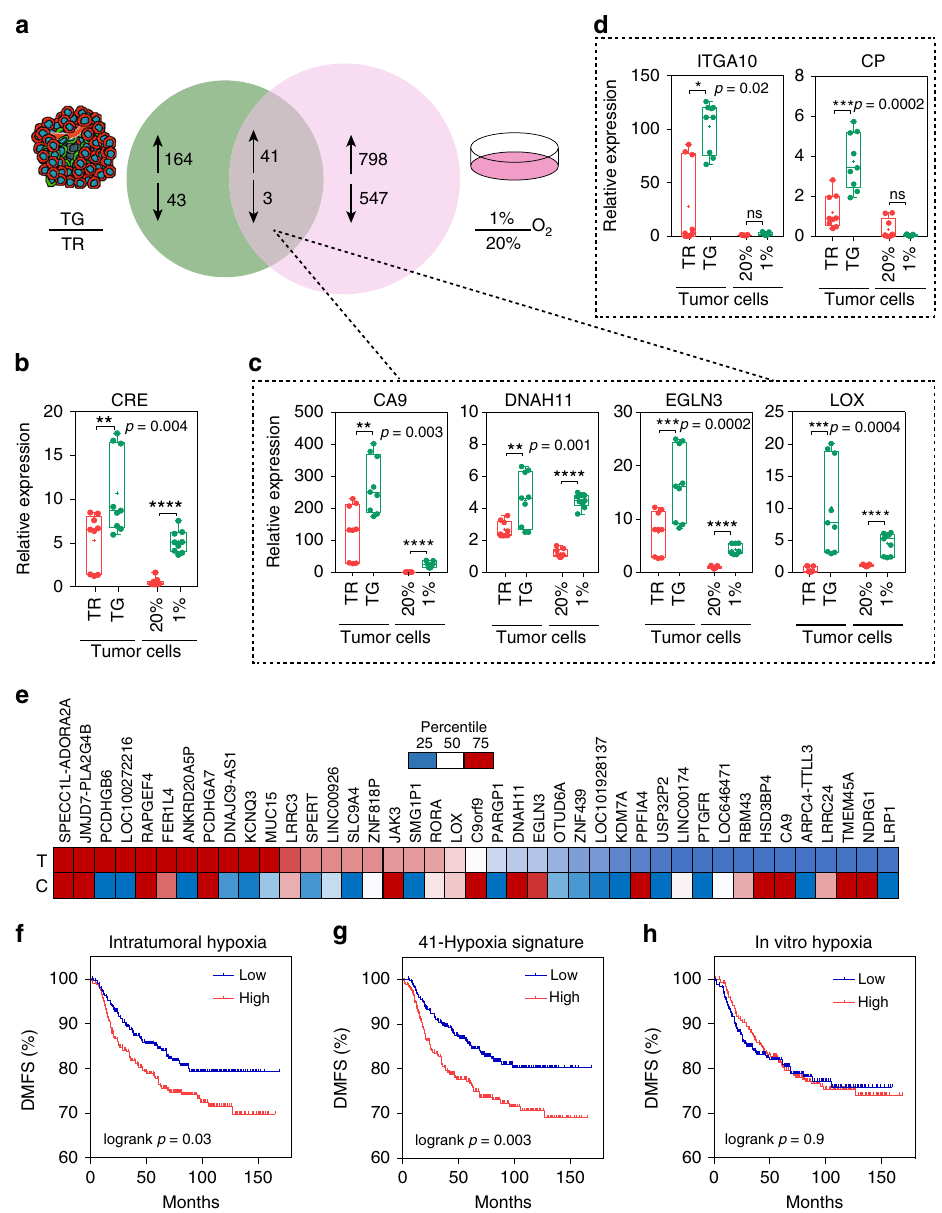
Fig. 5 Hypoxia fate-mapping system facilitates pro fi ling of intratumoral hypoxia. a Tumors derived from hypoxia fate-mapping MDA-MB-231 cells were harvested 2 weeks after implantation and sorted into DsRed + /GFP − or GFP + populations directly into Trizol ( N = 2). Venn diagram displaying the overlap of the number of genes with differential expression ( − 1.5 ≥ FC ≥ 1.5) in GFP + versus DsRed + tumor cells (green circle) and MDA-MB-231 cells exposed to 1% O 2 versus 20% O 2 (pink circle) (Supplementary Table 6). b – d Relative expression of mRNA measured by qPCR in tumor-derived cells (TG or TR) or MDA-MB-231 cells exposed to 20% or 1% O 2 in vitro, b CRE, c genes co-regulated by intratumoral and in vitro hypoxia (CA9, DNAH11, EGLN3, and LOX), and d genes exclusive to upregulation upon intratumoral hypoxia (ITGA10 and CP) (mean± SEM, N = 3, n = 3); **** P < 0.0001 TG versus TR and 1% versus 20% (two-tailed t -test). The box extends from the 25th to 75th percentiles, the median is marked by the vertical line inside the box, and the whiskers represent the minimum and maximum points. e Heat map of the 41-gene signature derived from the overlap of intratumoral and in vitro hypoxia. The distribution of the relative fold change of each gene in the 41-gene signature is displayed for GFP + versus DsRed + sorted tumor cells (T) or cells (C) exposed to 1% versus 20% O 2 conditions. Genes with fold change higher than 75% of the fold change of genes in the set are red and genes with fold change lower than 25% of the fold change of genes in the set are blue (Pearson correlation factor r = 0.84 and P = 9.6 × 10 − 7 ). f – h Microarray expression data from 664 breast cancer patients were used to perform multigene survival analysis ( n = 664; HGU133 plus 2.0 arrays, KMplotter). Kaplan – Meier analysis of distant metastasis-free survival (DMFS) of breast cancer patients strati fi ed by high or low expression by using f the 40 most induced genes by intratumoral hypoxia, g the 41-gene signature derived from the overlap of intratumoral and in vitro hypoxia, or h the 40 most induced genes by in vitro